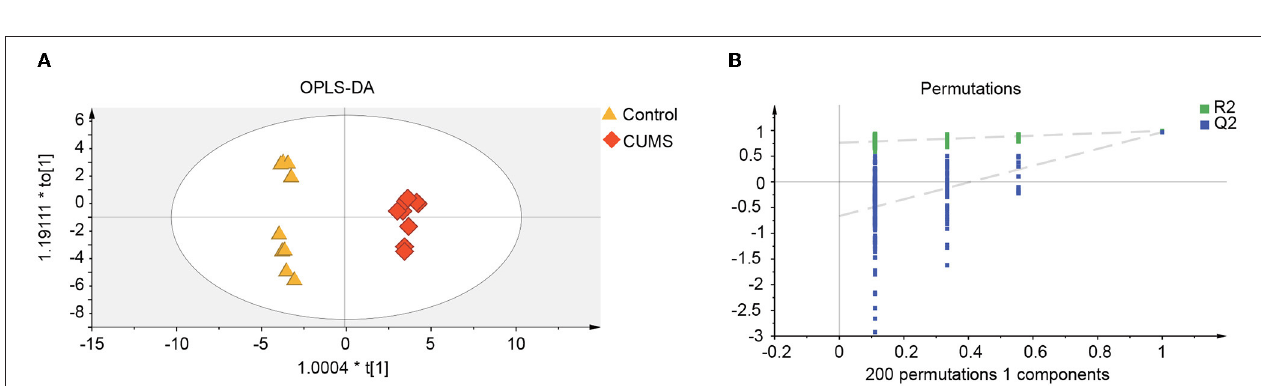
FIGURE 3 | Metabolomic fingerprint analysis of the PFC in orthogonal partial least-squares discriminant analysis (OPLS-DA). (A) OPLS-DA score scatter plot, with orange triangles and red diamonds representing the Control group and CUMS group, respectively; R2X [1] = 70%, R2Y [2] = 99.2%, Q2 = 96.8%. (B) Validation plot obtained from 200 permutation tests for the OPLS-DA model. R2 = 76.2% and Q2 = − 66.6%, n = 9.